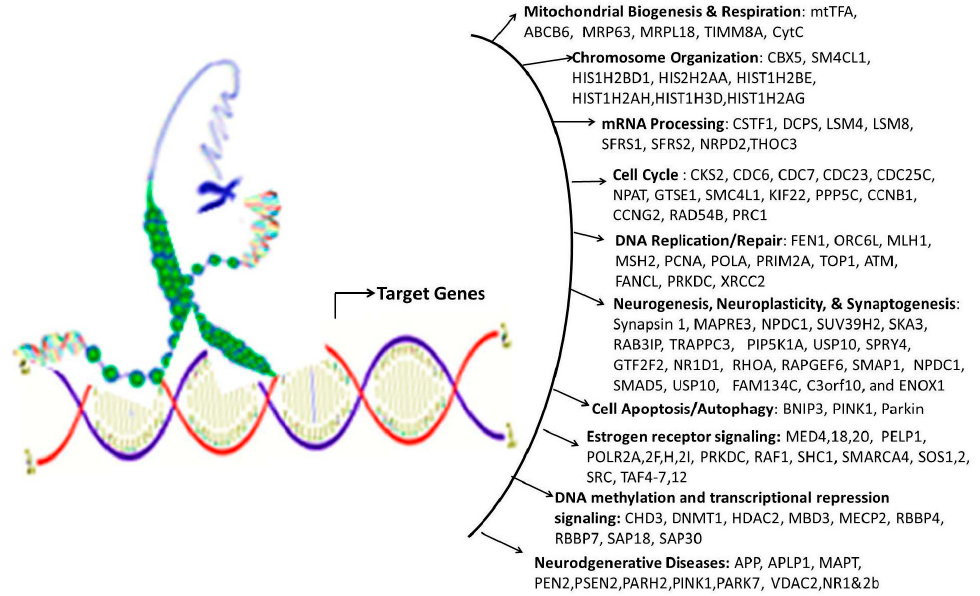
Figure 14. NRF1 regulating targets genes with diverse functions. NRF1 is depicted to recognize the palindromic sequence defined as YGCGCAYGCGCR, where Y and R indicate a pyrimidine or purine nucleotide, respectively, to recruit factors for the transcription of target genes, which are involved in many cellular processes.